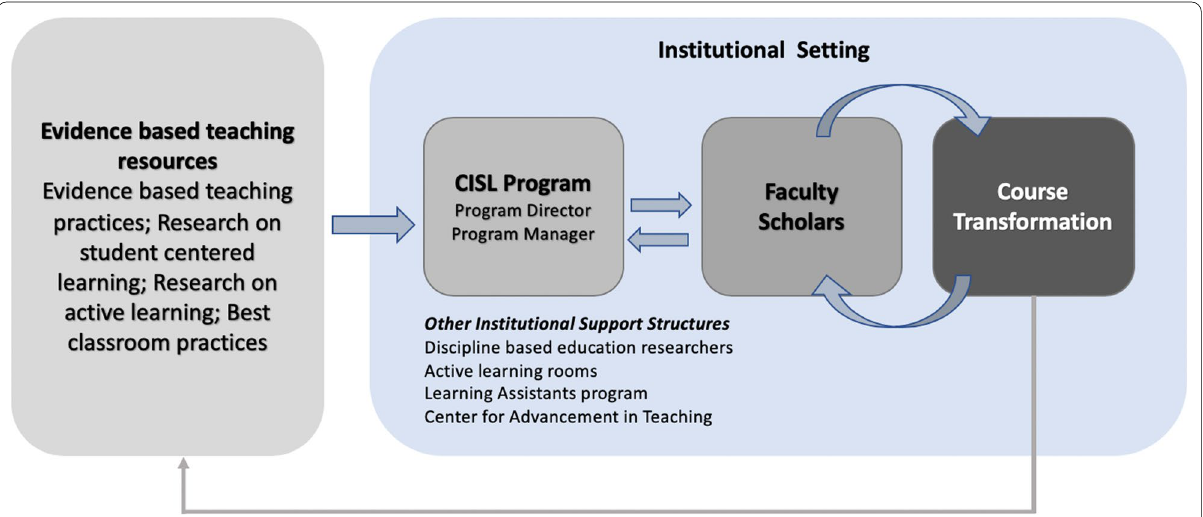
Fig. 1 Overview of the CISL Faculty Scholar program. The CISL program is one of the institutional support structures that serves as the communication link between the resources on evidence-based teaching practices and Faculty Scholars. There is regular feedback (arrows) between CISL program and Faculty Scholars. Faculty Scholars implement course transformations which in turn provides feedback that is incorporated into the next iteration of course transformation as indicated by the rounded arrows. Course transformations by Faculty Scholars can contribute through peer-reviewed publications (grey